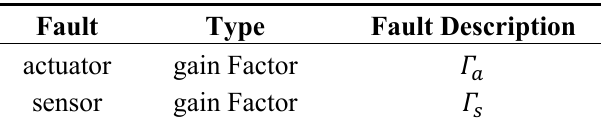
Table 3. The faults